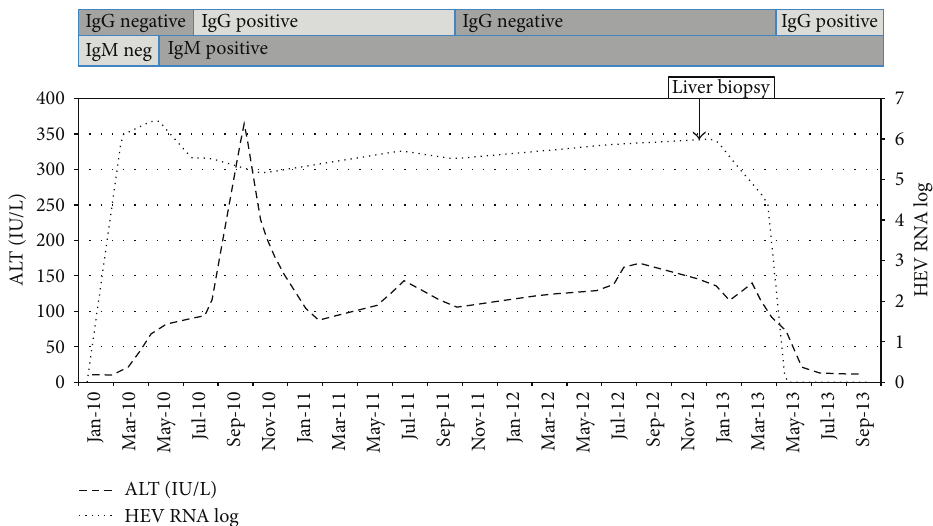
Figure 1: Evolution of alanine transaminase (ALT) levels, Hepatitis E virus (HEV) RNA levels, and HEV serology.